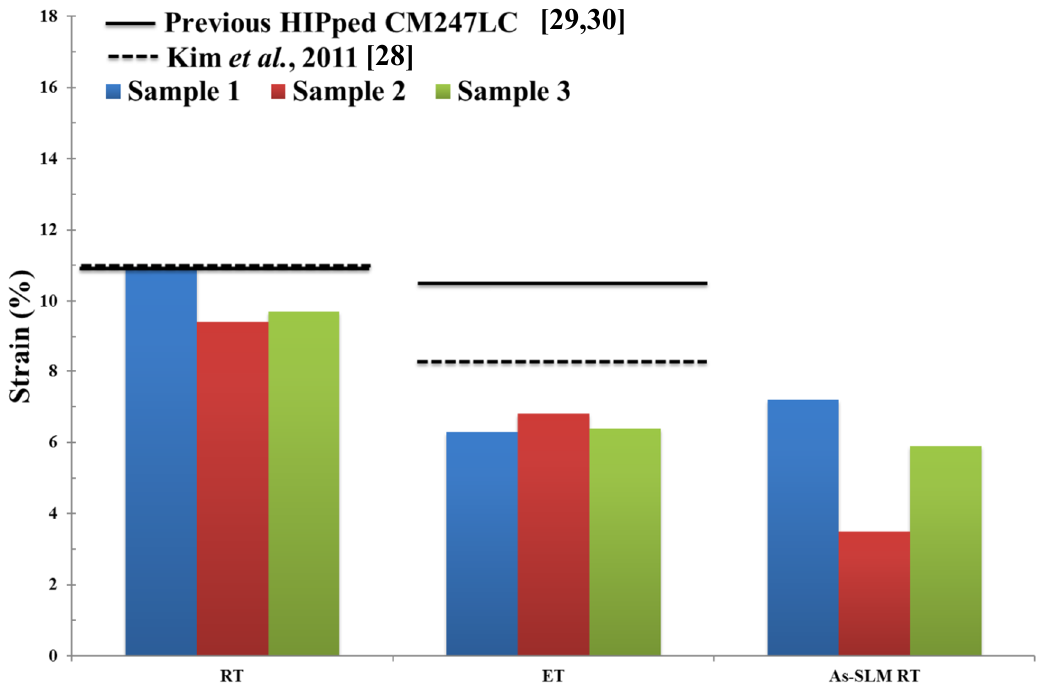
Figure 20. Bar plot showing 0.2% proof stress of HIPped CM247LC at RT and ET, as well as SLM-processed CM247LC at RT for comparison [1]. Properties for conventionally cast and heat treated CM247LC are represented by the dashed line [28] and previous results of HIPped CM247LC undertaken in AMPLab by the solid line [29,30]. Micromachines 2020 , 11 , x FOR PEER REVIEW